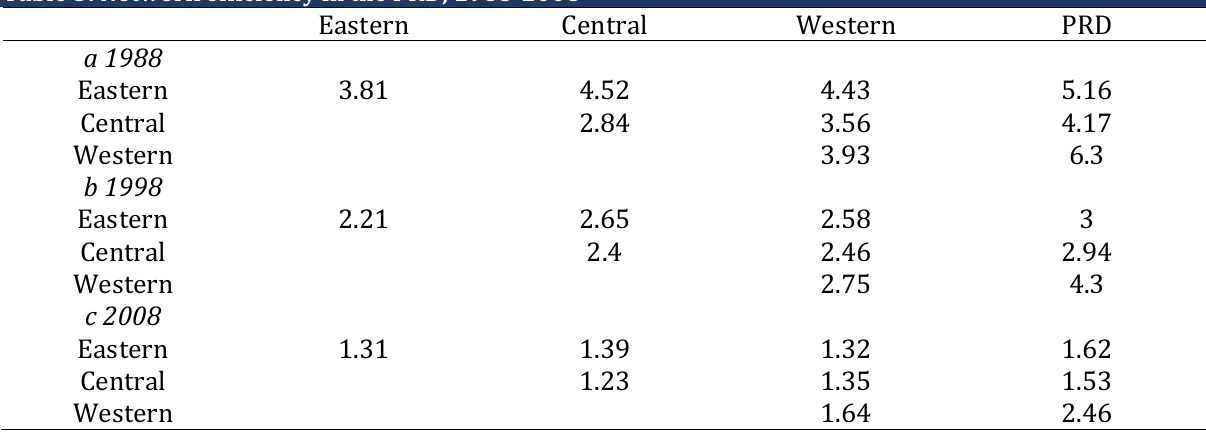
Table 3: Network efficiency in the PRD, 1988-2008 Eastern Central Western